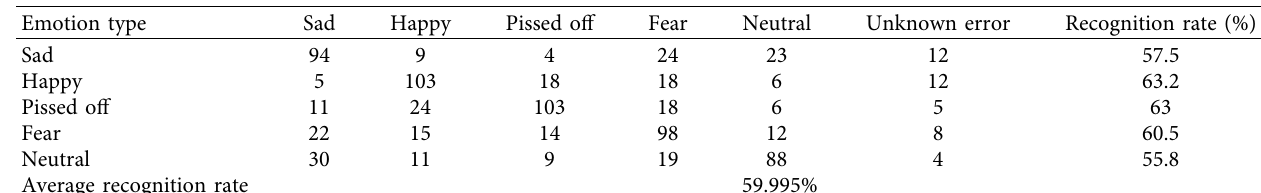
Table 5: 210 long-term speech recognition results in the 810 training set.